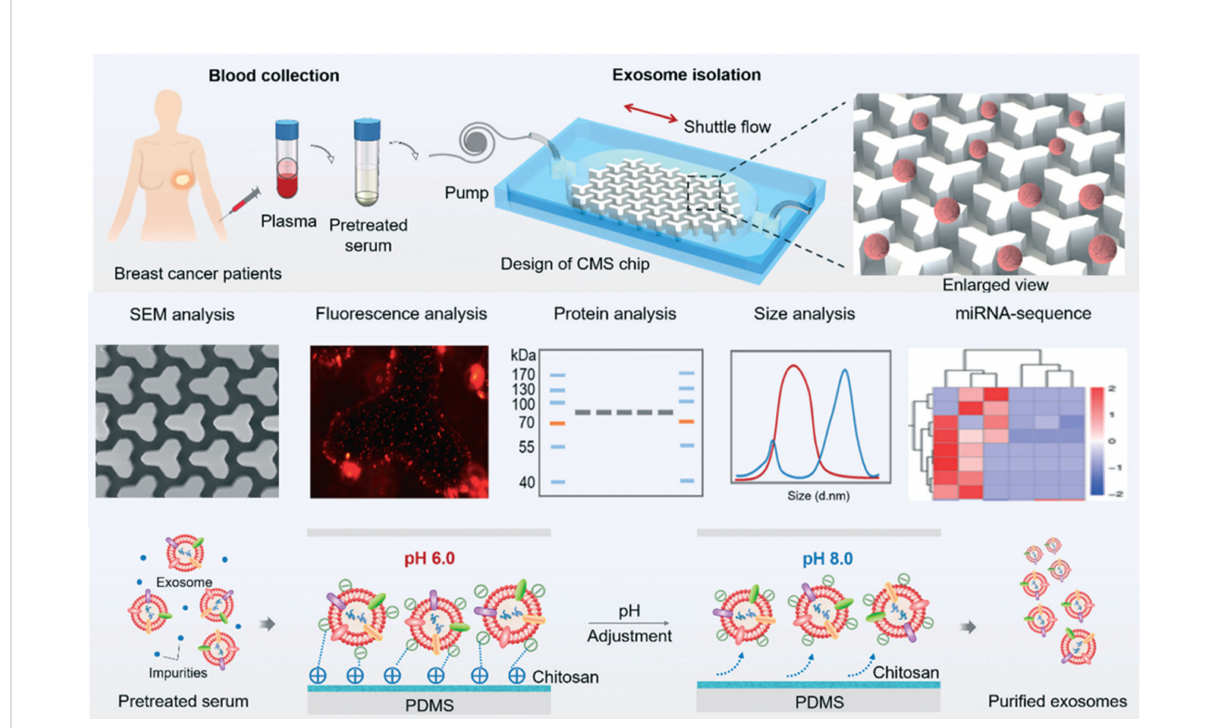
FIGURE 10 CS-based liquid biopsy for interrogation and elimination of circulating materials. Chitosan-based micro fl uidic platform for tumor-derived exosome isolation and analysis. Reprinted from (135), Copyright (2021) Royal Society of